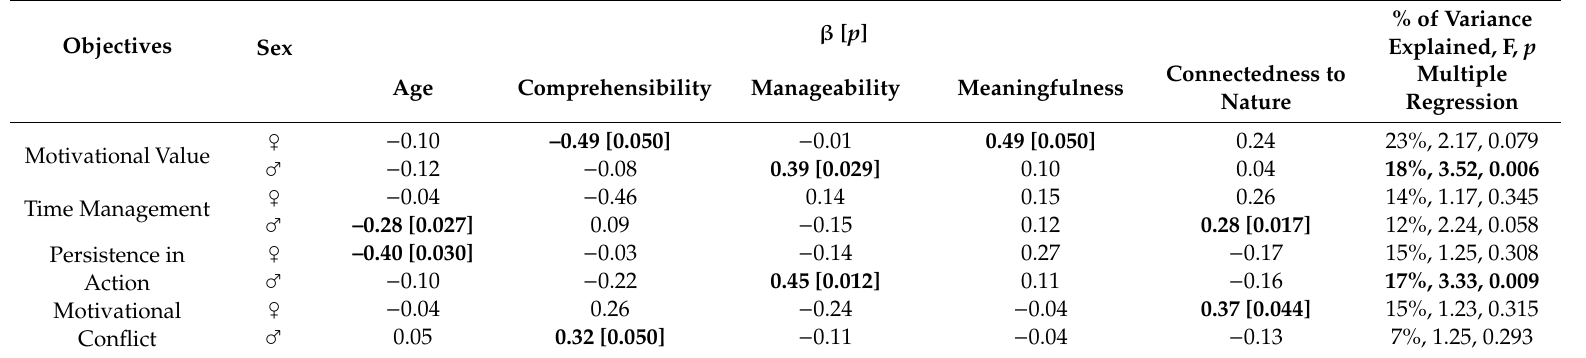
Table 4. Multiple regression with the motivational function of the objective (response variable) and age, sense of coherence, and connectedness to nature (explanatory